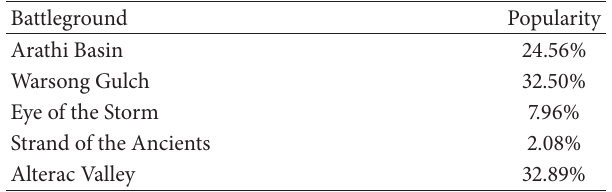
Table 3: Popularity of specific